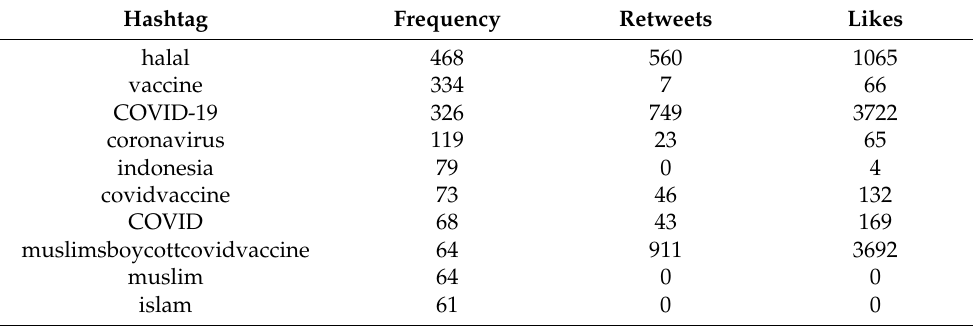
Table 1. List of the 10 most frequent